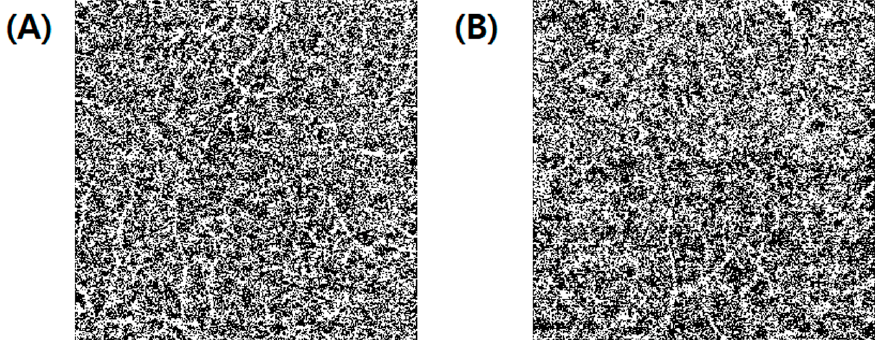
Figure 6. Representative optical coherence tomography angiography images of the choriocapillaris layer and choriocapillaris flow features in two patients with acute myocardial infraction with low and high cardiovascular risk scores, respectively. ( A ) Case #1 ASCVD 6.2, GRACE 76, count of CCP 2522, average size of CCP 15.22, signal void area of CCP 39.49. ( B ) Case #2 ASCVD 41.4, GRACE 179 count of CCP 2482, average size of CCP 15.67, signal void area of CCP 40.25. CCP, choriocapillaris; ASCVD, atherosclerotic cardiovascular disease; GRACE score, Global Registry of Acute Cardiac Events score.